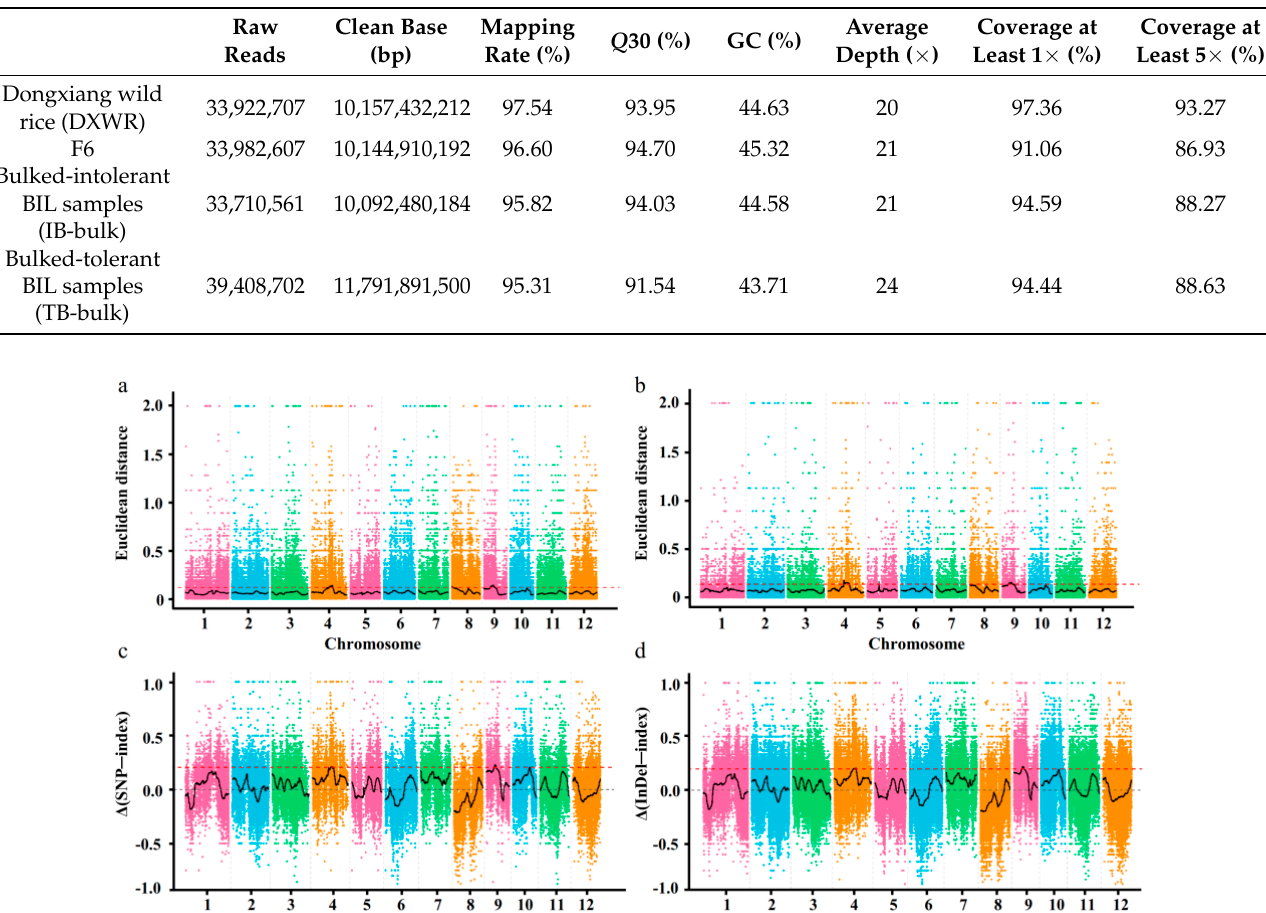
Table 1. The quality of sequencing data and analysis of sequencing depth and coverage.